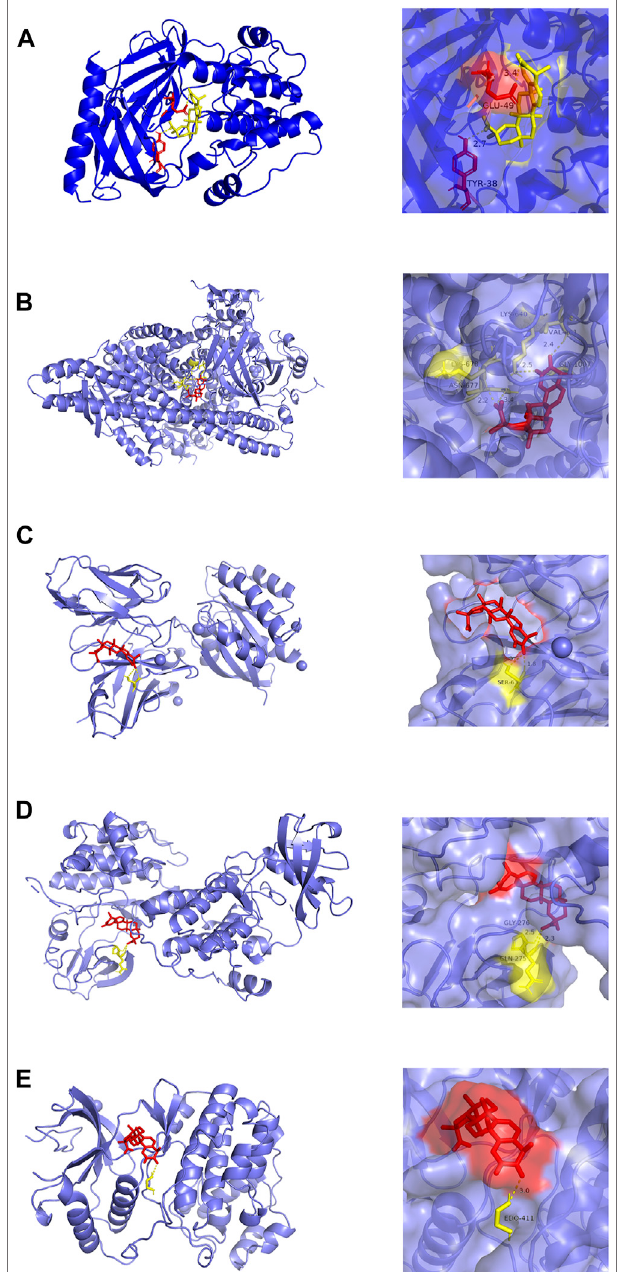
FIGURE6| Molecularmodelsofcelastrolbindingtothe5mostprobable binding targets. Proteins (A) AKT1, (B) PIK3R1, (C) HRAS, (D) SRC, (E) MAPK1 are shown interacting with a celastrol molecule. The binding amino acidic sites and other details are shown on the right.